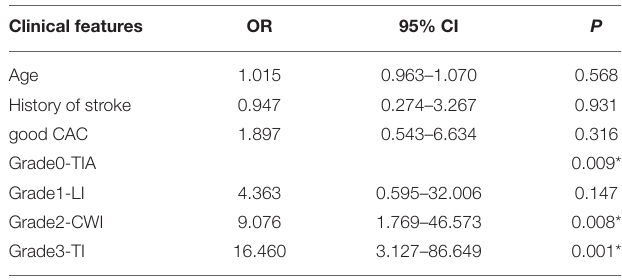
TABLE 3 | Multivariable models (Enter) of the association between APCV and clinical and radiologic markers in patients with ICAO. Clinical features